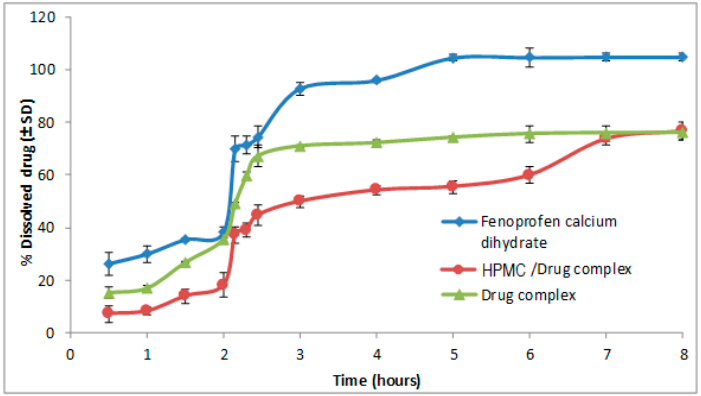
Figure 1. Effect of HPMC/drug complex on the dissolution of fenoprofen calcium dihydrate at pH = 1.2 for 2 h and then continued in pH = 6.8 for 6 h.